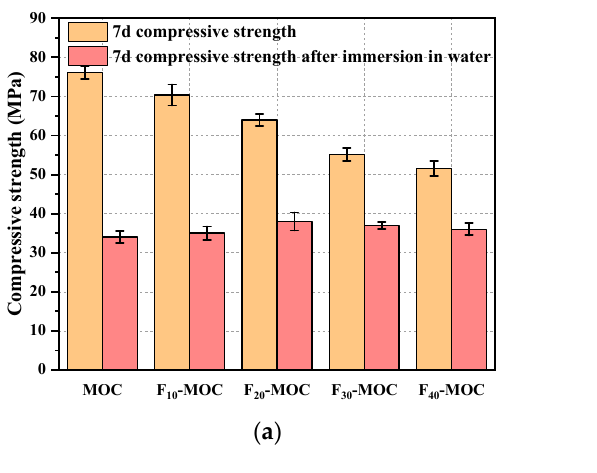
Figure 4. Water resistance of fly ‐ ash–MOC composite binary system: ( a ) 7 d compressive strength; and ( b ) 7 d strength residual coefficient after immersion in water.